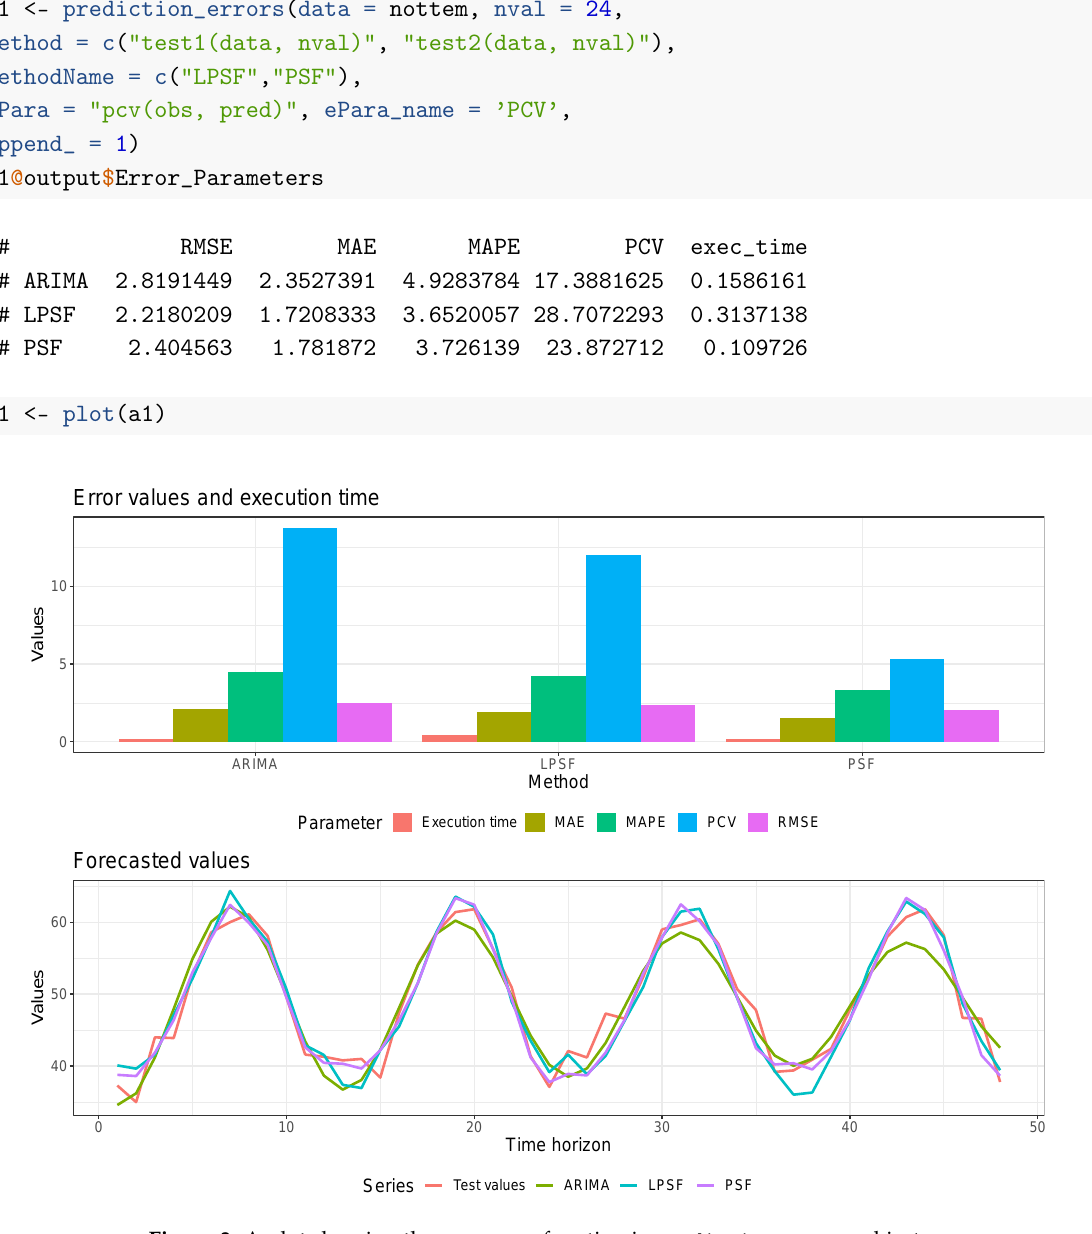
Figure 3. A plot showing the new error function in prediction_errors